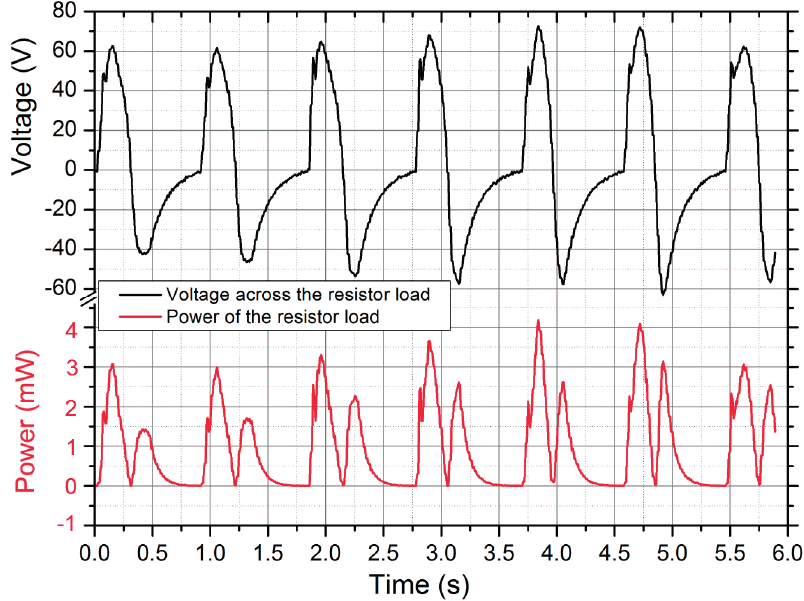
Figure 7. The voltage across the resistor load and the resulting power delivered to the resistor.